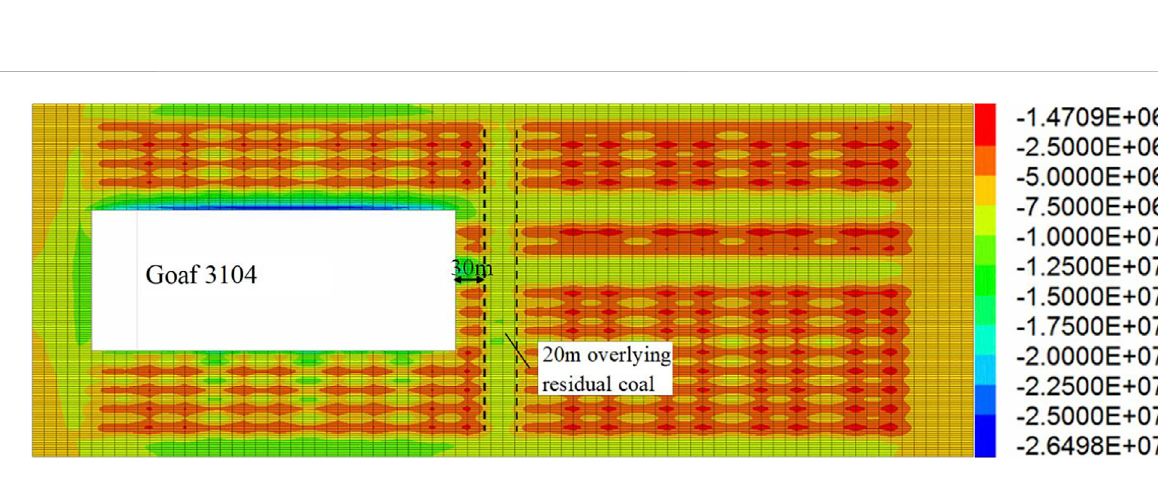
FIGURE 23 Cloud diagram of vertical stress distribution at 20m of overlying residual coal pillar